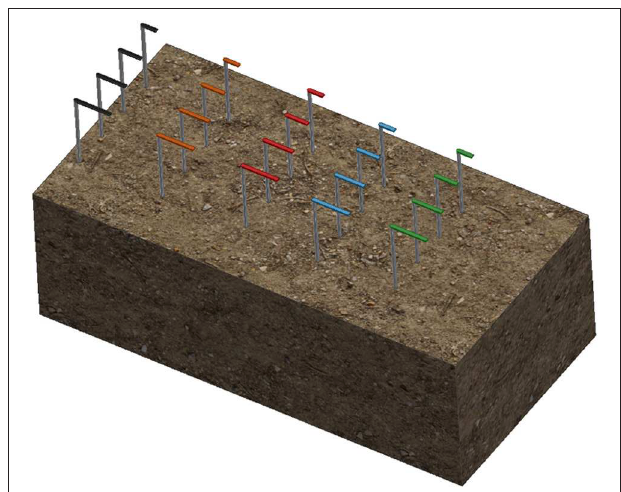
FIGURE 2 | Placement of all samples in the soil burial location within Centennial Parklands,